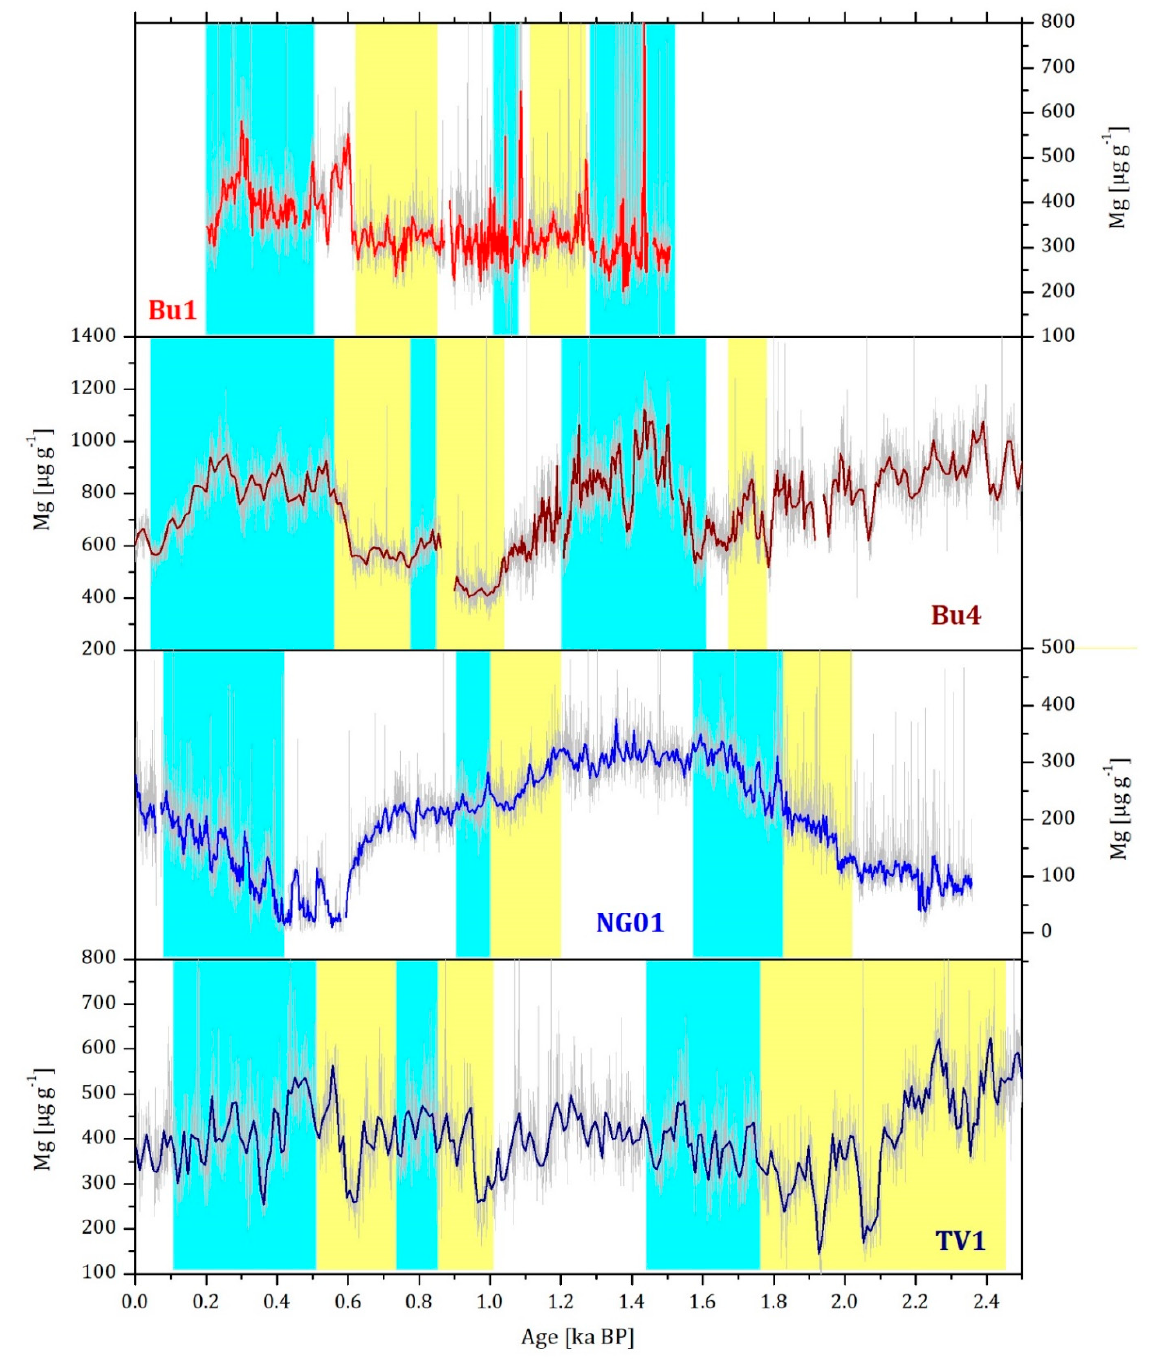
Figure 5. Mg concentration of four speleothems Bu1 and Bu4 from Bunker Cave as well as NG01 and TV1 from the Herbstlabyrinth cave system. The trace element data were smoothed with a 10-point (NG01 and TV1) and 20-point (Bu1 and Bu4) running median and, thus, have an average temporal resolution between 1.6 and 9.7 years. The raw data are shown in light grey and the respective running medians as colored lines. Blue bars indicate phases of higher δ 18 O values and yellow bars phases of lower δ 18 O values in the individual stalagmites (cf. Figure 3).